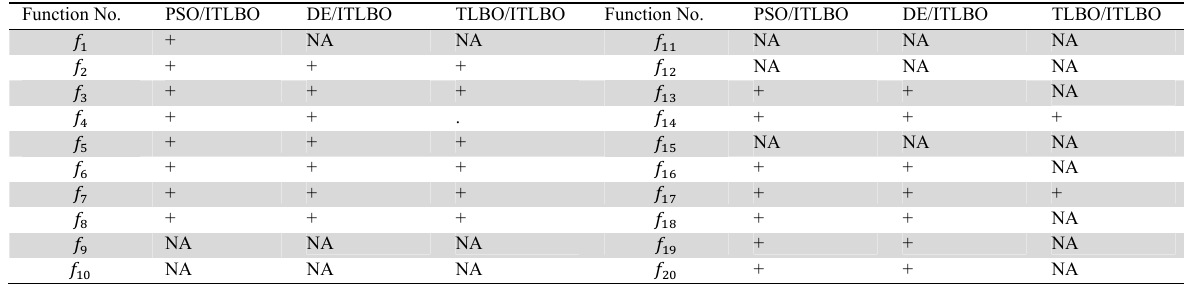
(values in brackets in the table are the absolute values of FEs) t value , significant at a 0.05 level of significance by two tailed test using table 2. Function